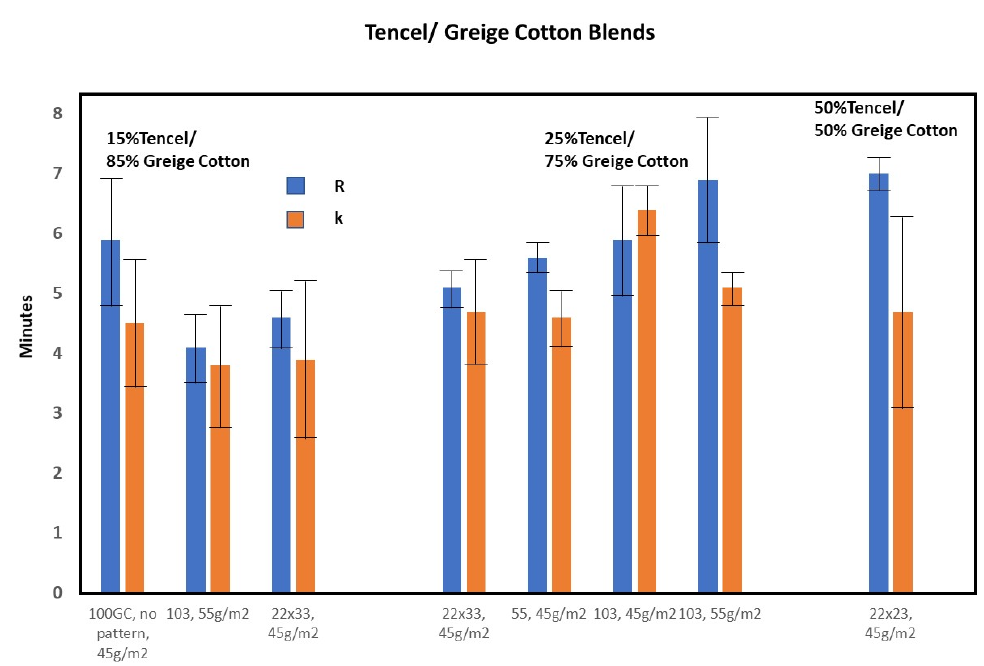
Figure 4. A comparison of thromboelastography ( R = fibrin formation = blue, k = clot formation = orange) results for three nonwoven compositions, wherein density and mesh were varied. SD = standard deviation, n = 3.